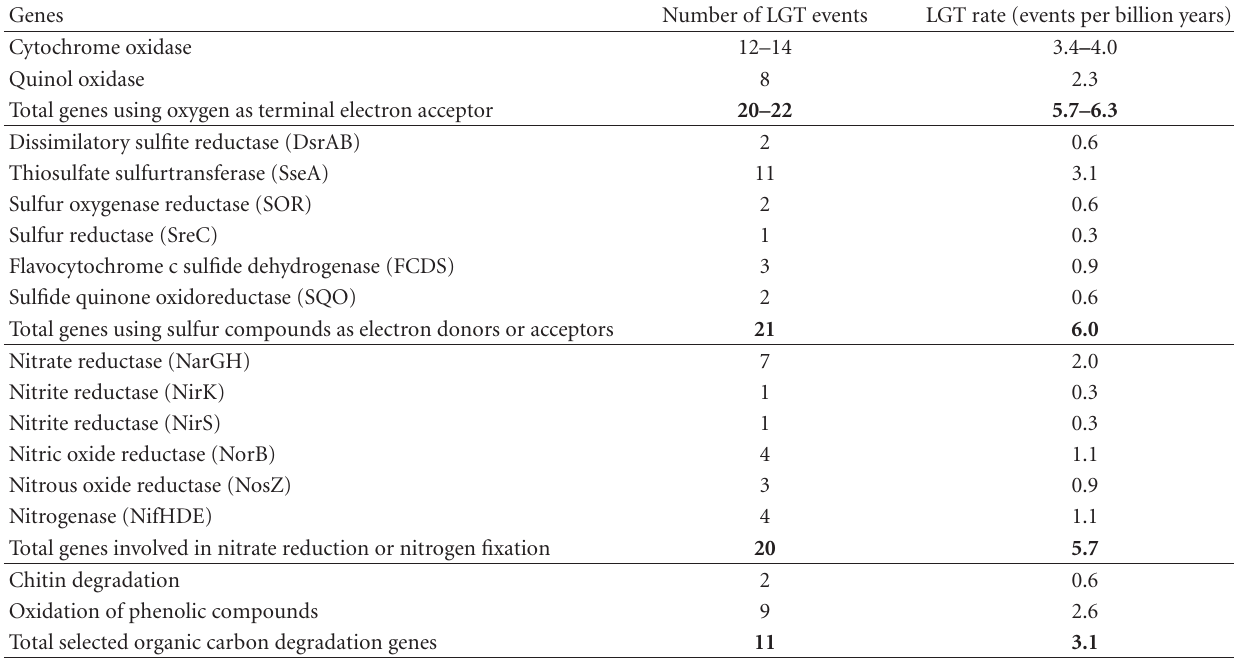
Table 5: Calculated lateral transfer rates across the domain